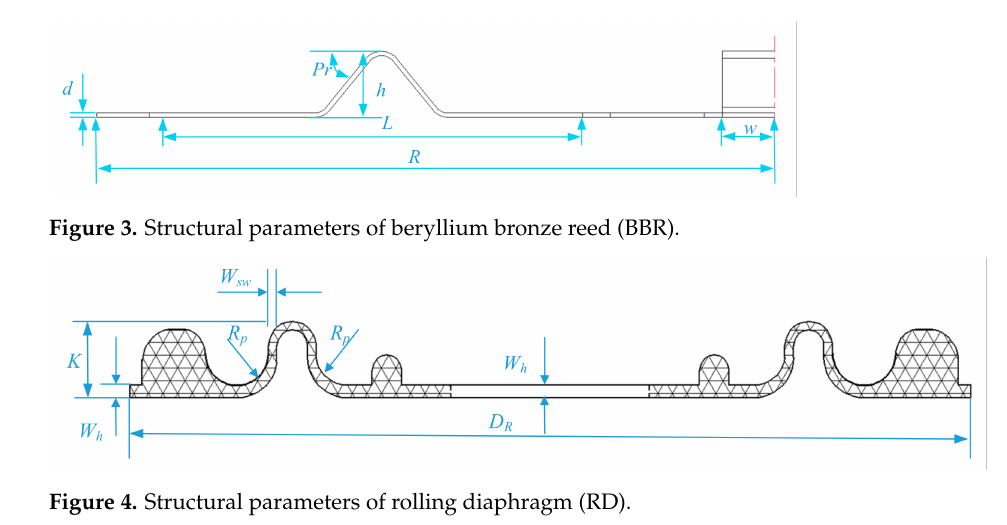
Figure 4. Structural parameters of rolling diaphragm